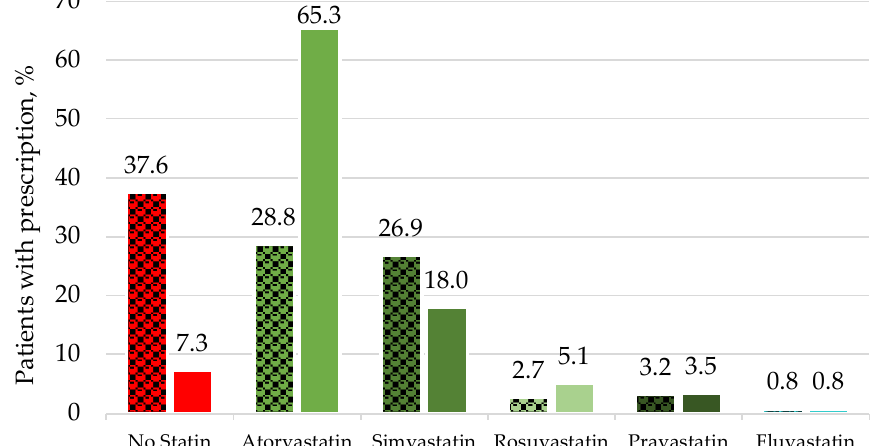
Figure 1. Changes of statin application during hospital treatment. The distribution of statin application is displayed for admission or at ambulatory contact at the angiolocigal outpatient department (dotted bars) and discharge, or after ambulatory presentation at the angiological outpatient department (solid bars), in %. Columns in red display no statin treatment, columns in green display statin treatment (green: atorvastatin, dark green: simvastatin, light green: rosuvastatin, olive: pravastatin, greenish-blue: fluvastatin).